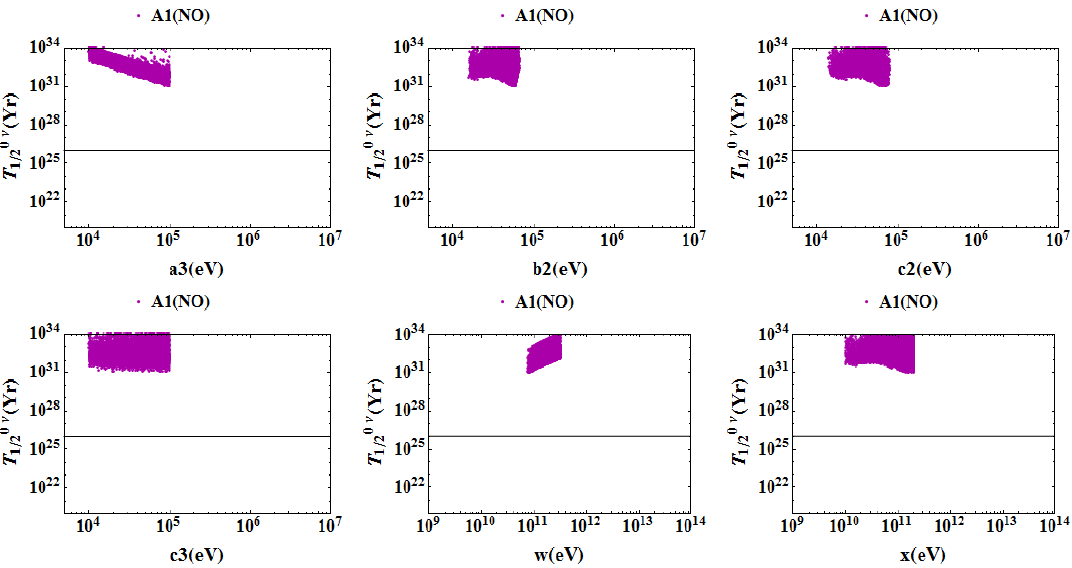
Figure 19 . Total contribution to half-life governing NDBD as a function of the model parameters for the class A1. The horizontal line represents the KamLAND-Zen lower limit.